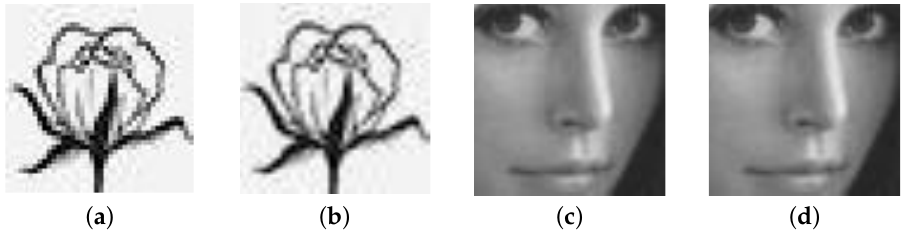
Figure 21. The original image of ( a ) flower and ( c ) lena, the stored image of ( b ) flower and ( d )